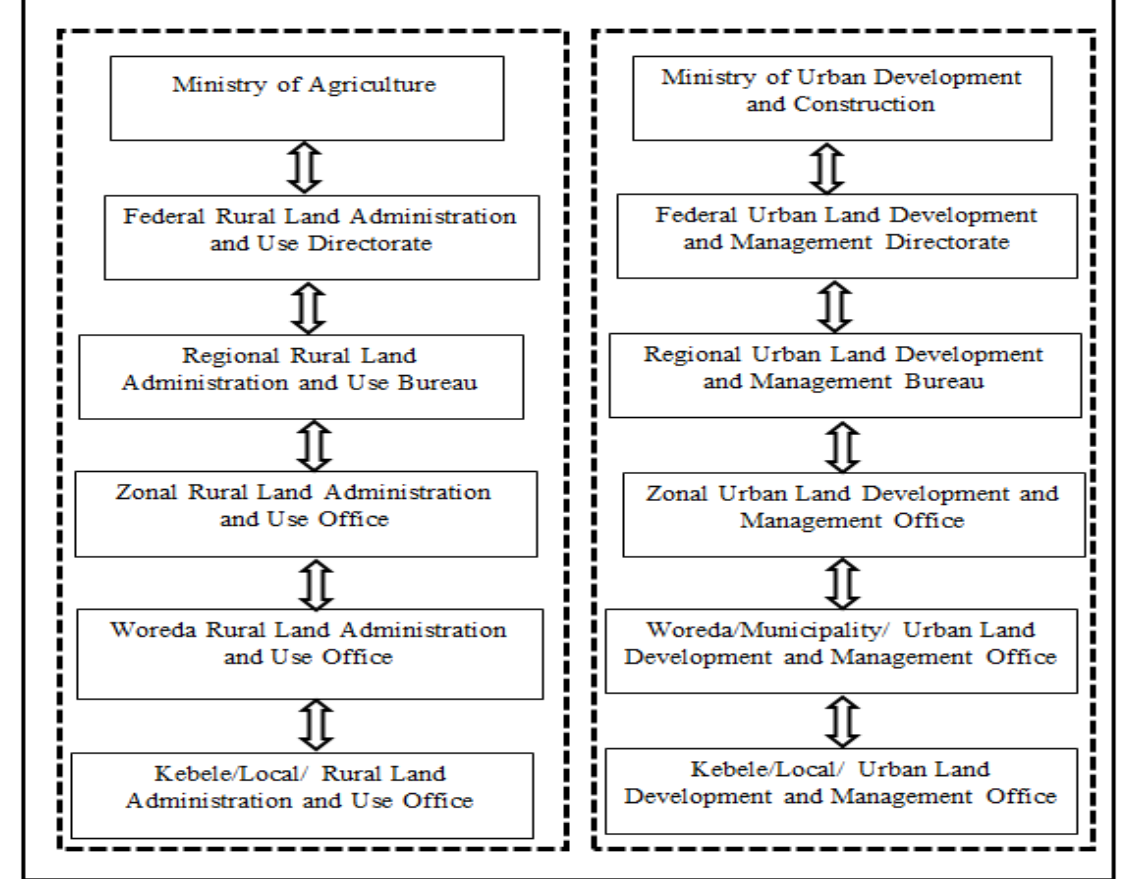
Figure 1. The existing isolated tiers of urban and rural land administration institutions. Source: Wubie et al. [21].